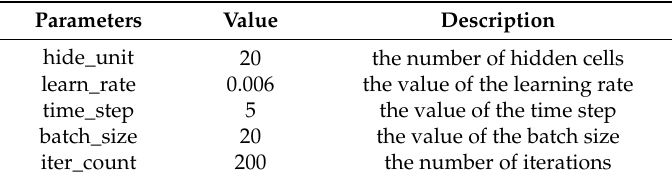
Table 4. Initial parameters of the FFLSTM.